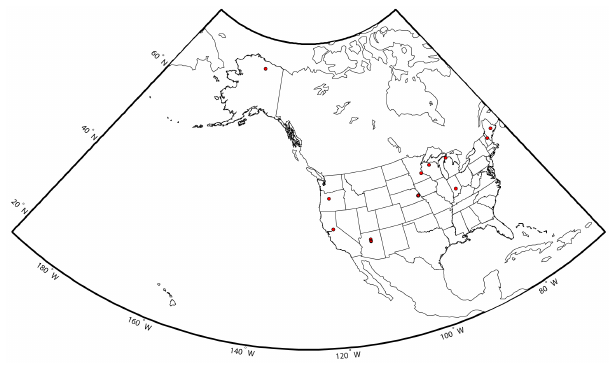
Figure 1. Location of sites presented on the USA map. Many sites which are closer together may appear as a single point on the